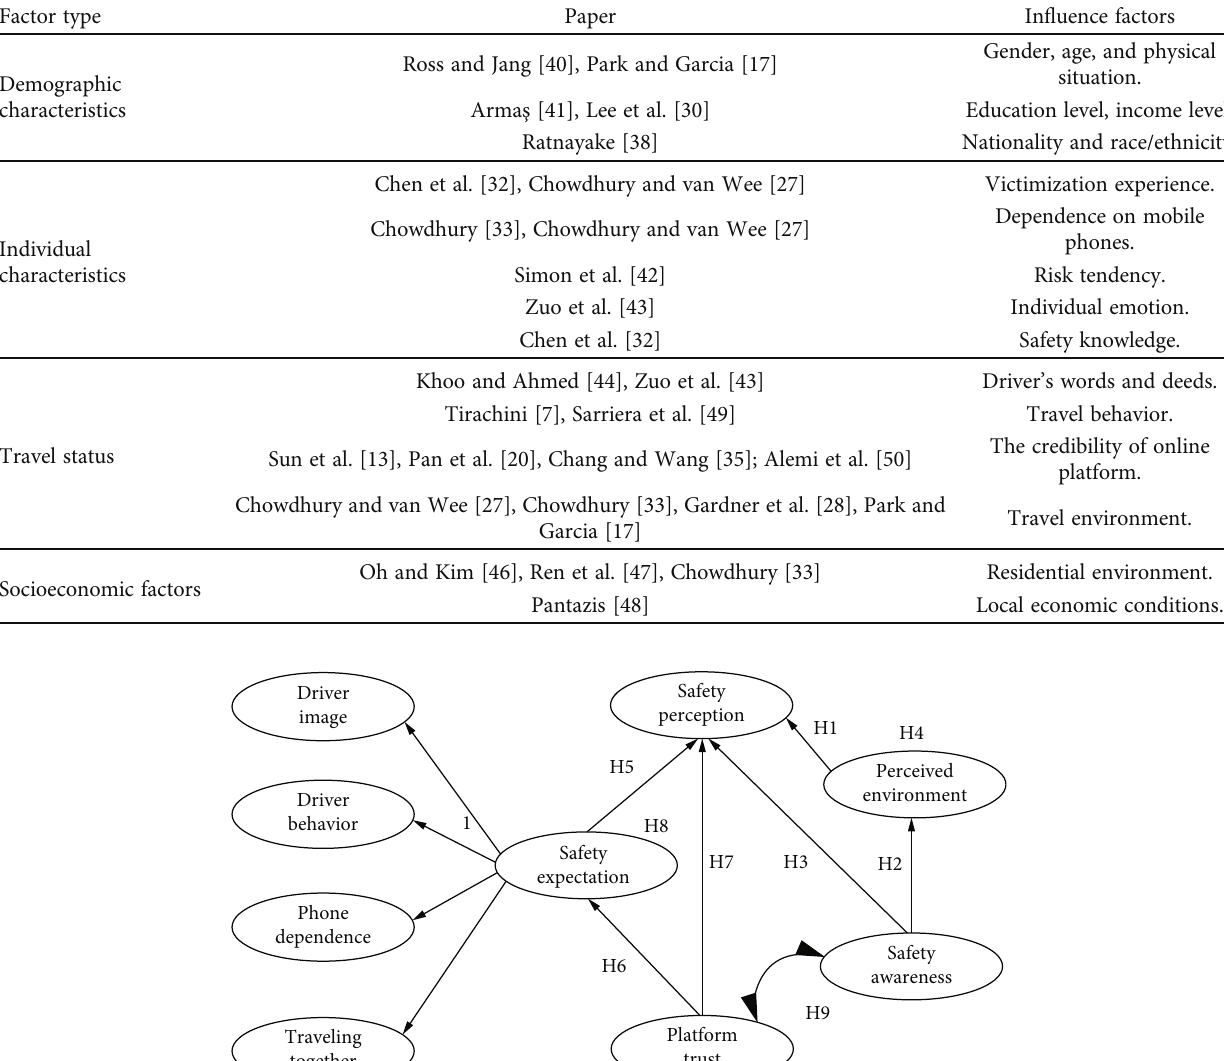
Table 2: Factors a ff ecting safety perception.